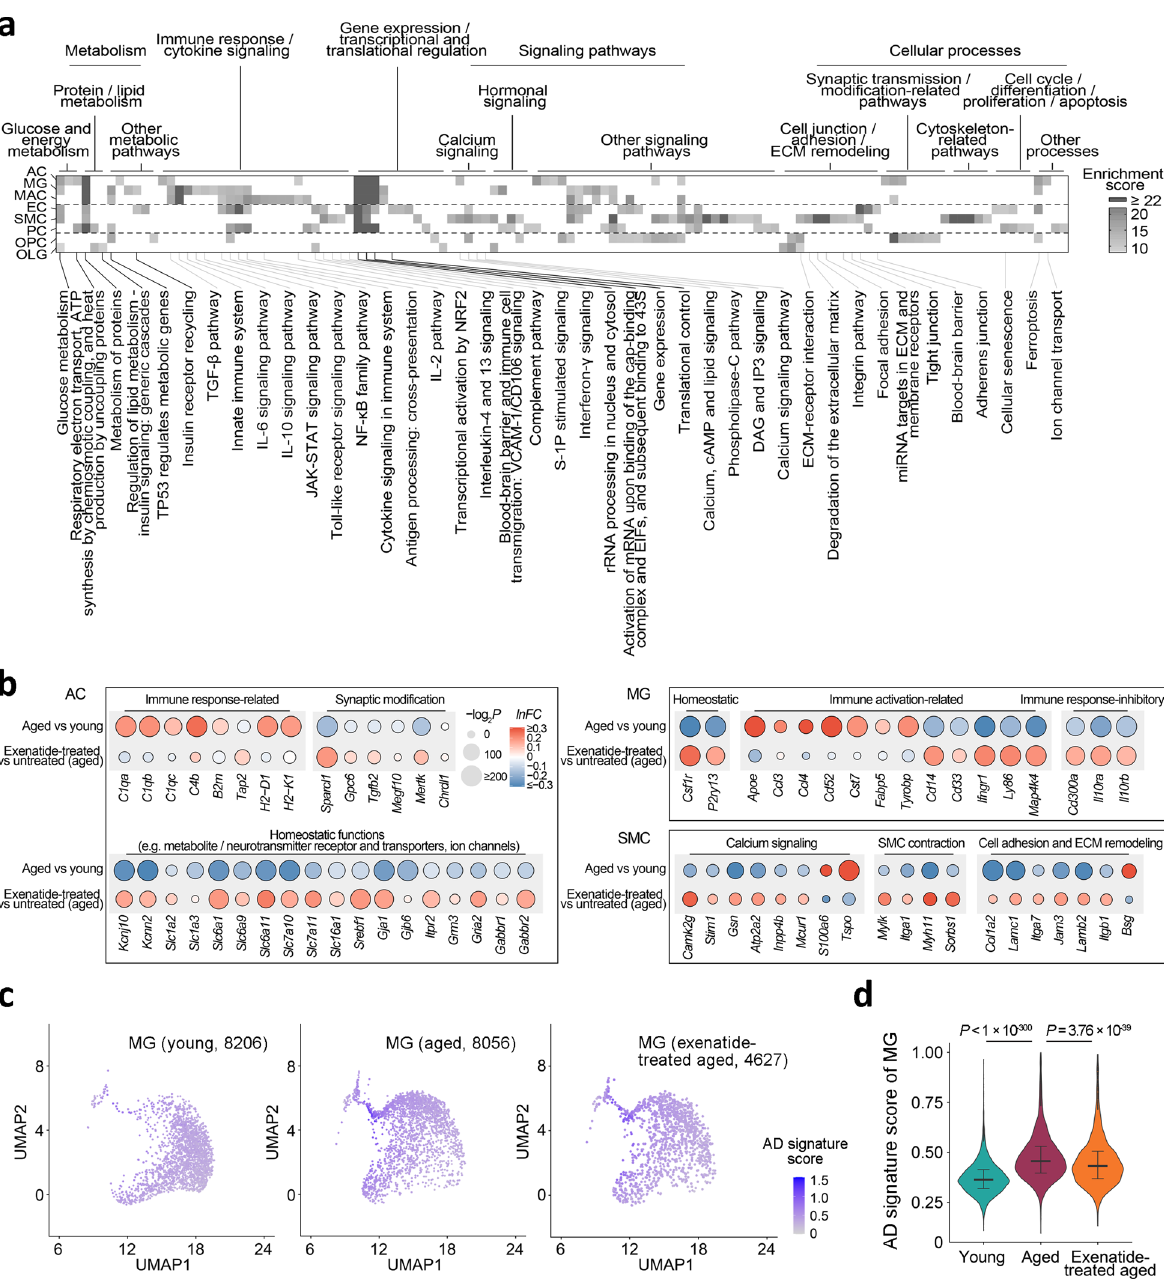
small-molecule GLP-1RAs 27 – 29 , which may need to cross the BBB to act on the cell type target(s) necessary to attain any centrally mediated anti-brain aging effects.